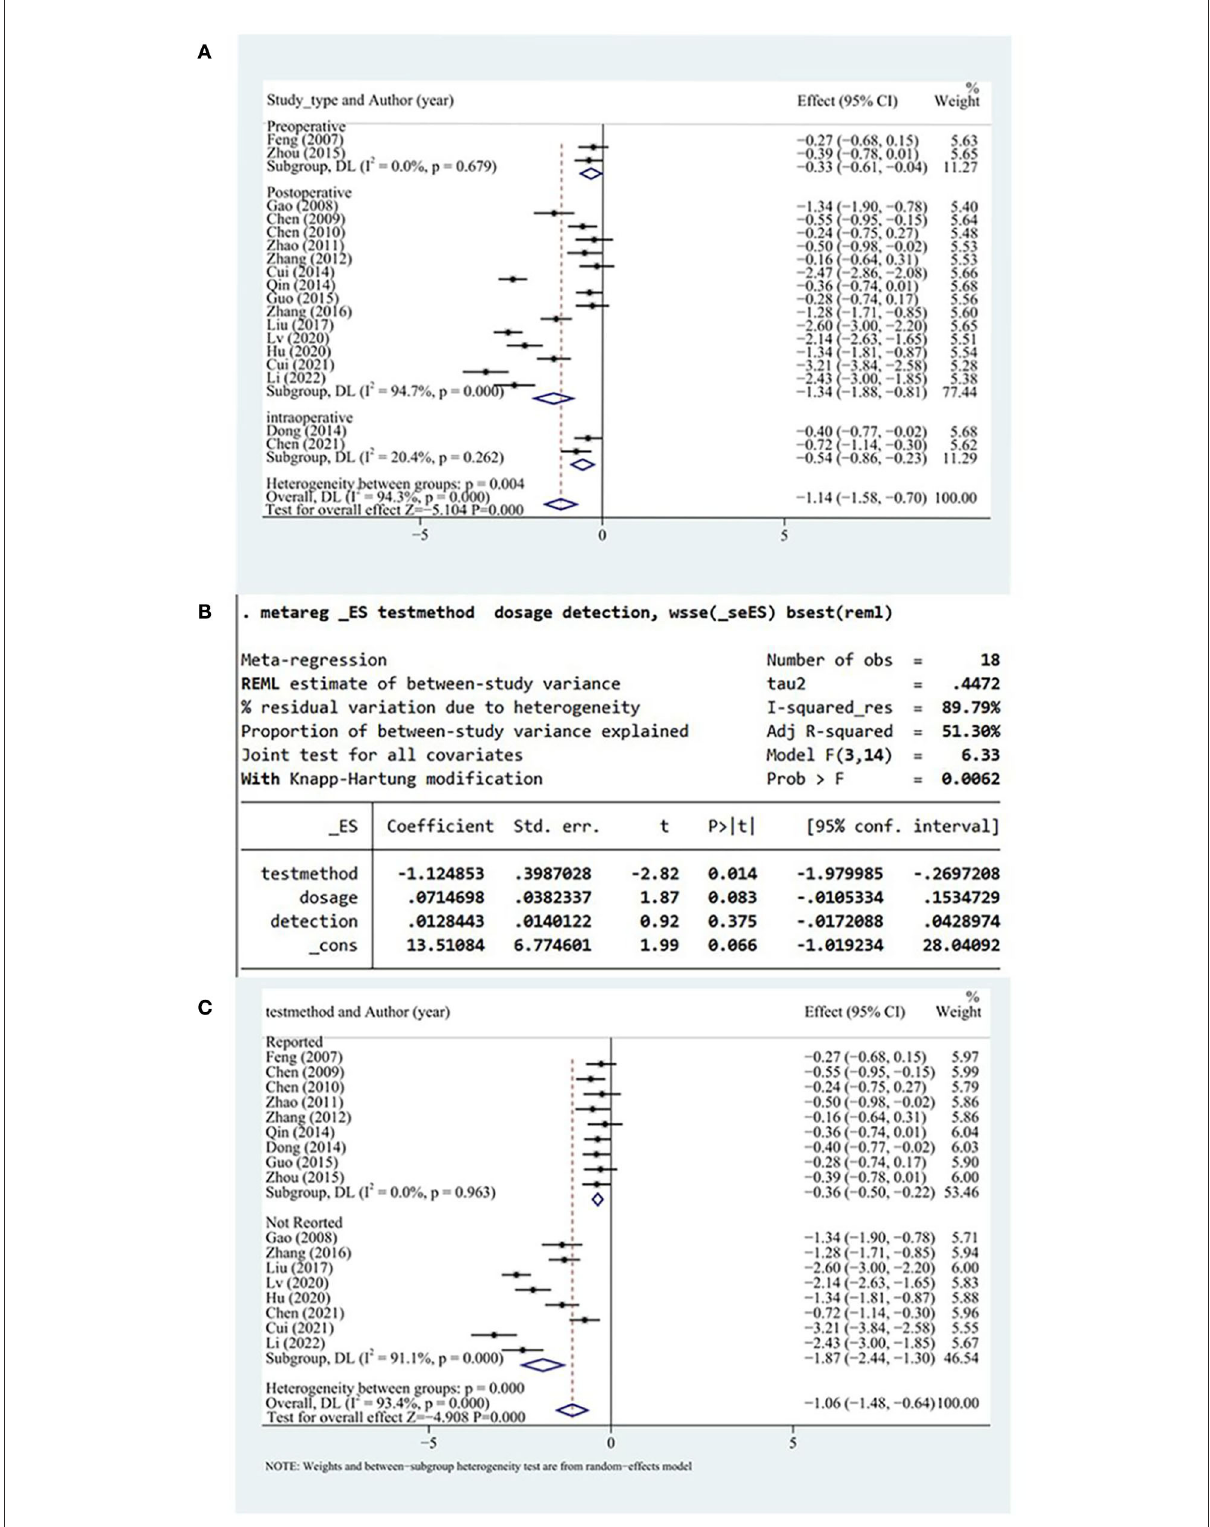
FIGURE5 (A) hs-CRP subgroup analysis. (B) Results of meta-regression. (C) Subgroup analysis of test methods. Hs-CRP; high sensitivity C-reactive